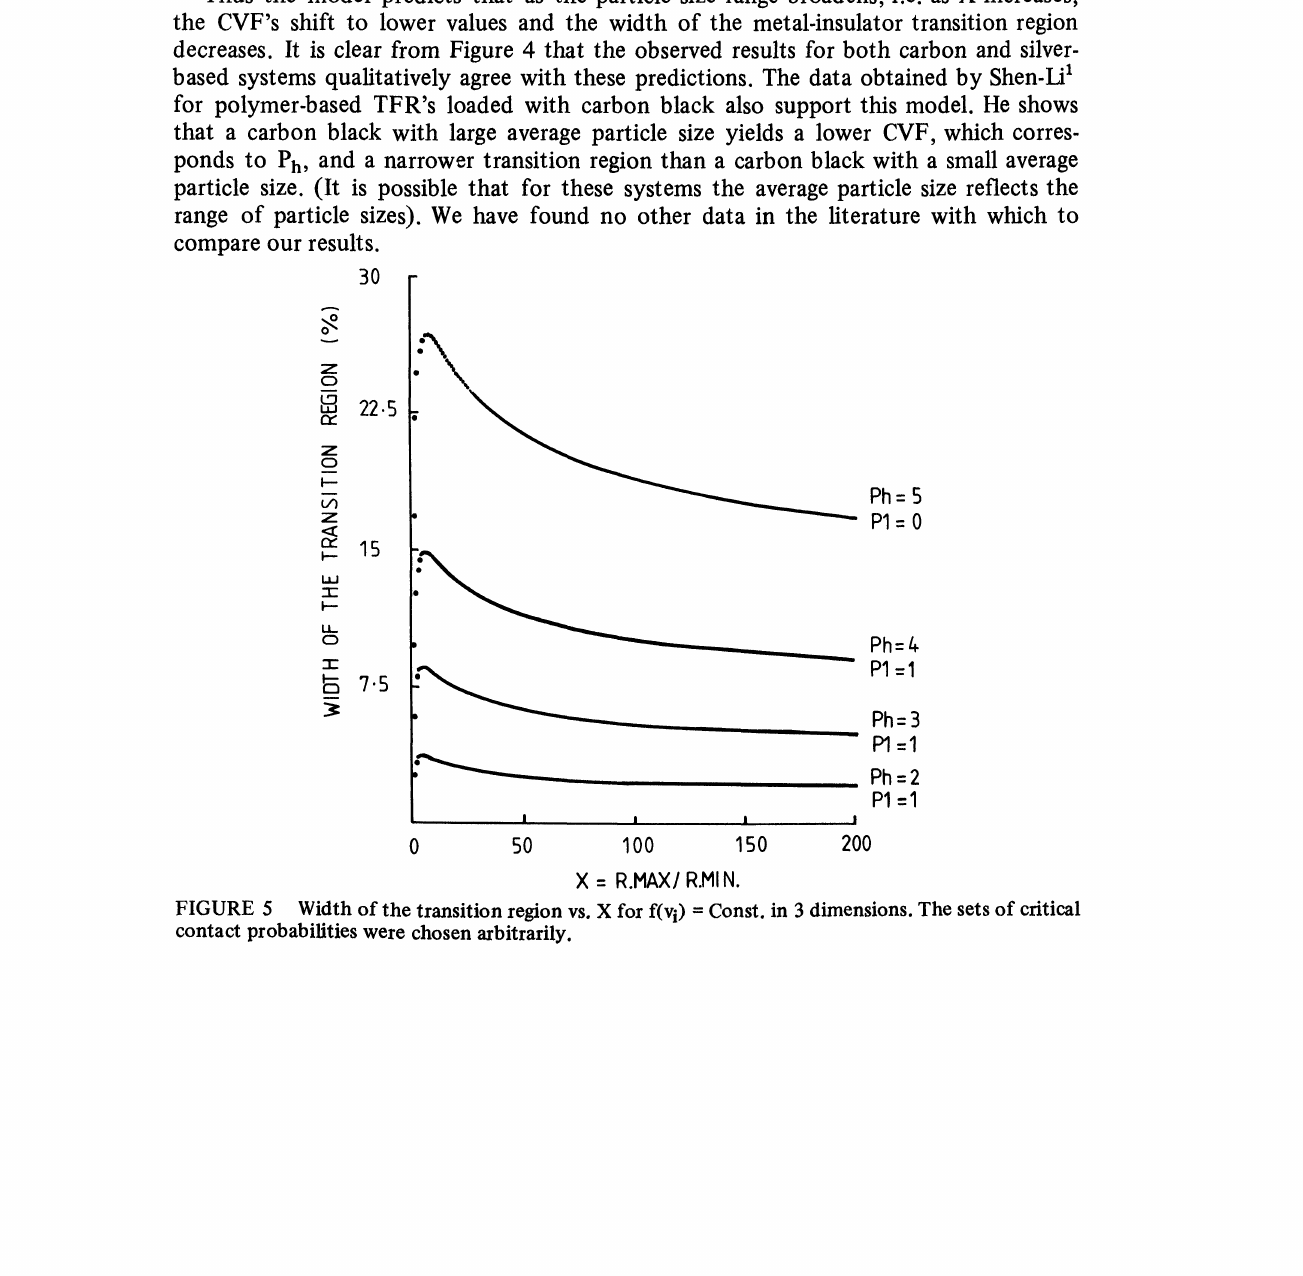
Width of the transition region vs. X for f(v i) Const. in 3 dimensions. The sets of critical contact probabilities were chosen